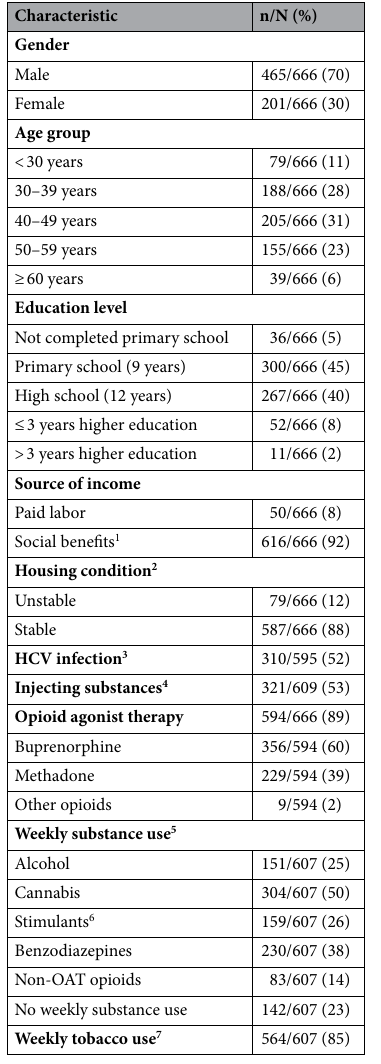
Table 1. The table presents baseline characteristics of the cohort (N = 666). 1 Social benefits include disability, disease and unemployment benefits and work assessment allowance. 2 Stable housing included living in owned or rented housing or at an institution, unstable housing included homelessness, living at temporary camping sites or with friends or family. 3 Hepatitis C virus infection, defined as non-zero values on a quantitative HCV- RNA assay at baseline. 4 Self-reported injection of any substance during the 6 months prior to the first health assessment. 5 Self-reported substance use on a minimum weekly basis during the 12 months prior to the first health assessment. 6 Amphetamine, methamphetamine or cocaine, 7 Self-reported tobacco use (smoking or snuff) on a minimum weekly basis during the 12 months prior to the first health assessment.